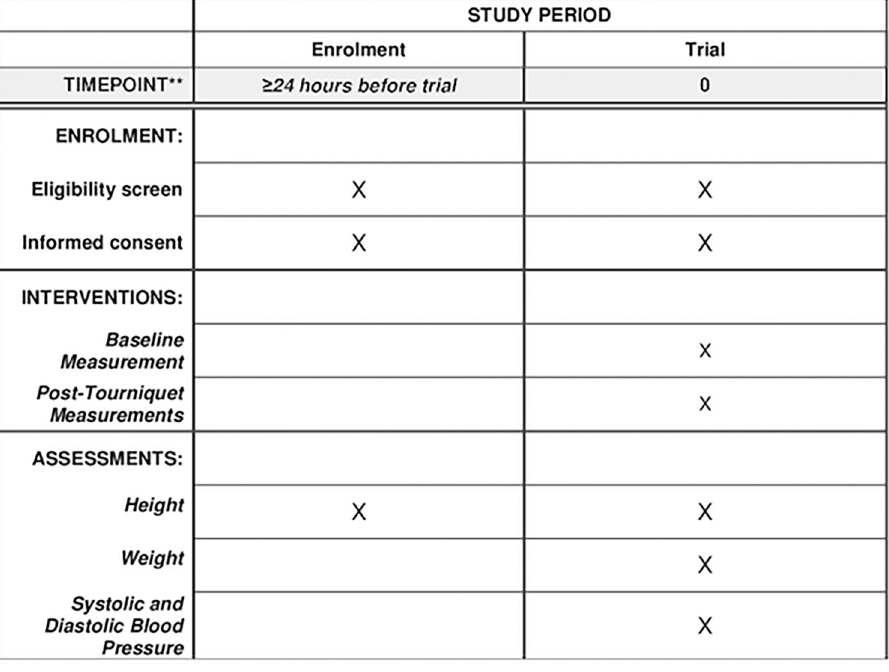
Fig 1. Schedule of enrollment, interventions, and